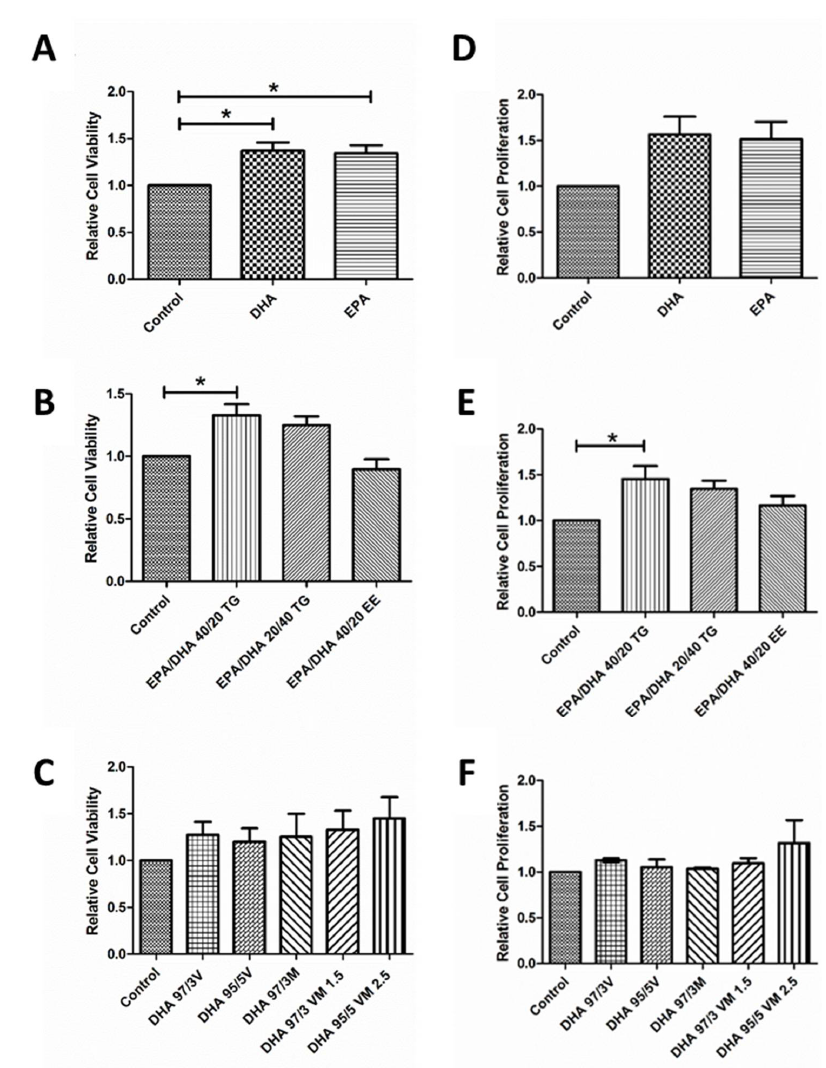
Figure 2. Graphs showing relative cell viability ( A – C ) and proliferation ( D – F ) compared to a control group under normal conditions of groups 1, 2, and 3 of eicosapentaenoic acid / docosahexaenoic acid (DHA/EPA) formulations, respectively ( D – F ). For comparisons, one-way ANOVA with the Bonferroni post-hoc test were used. Data are expressed as mean ± SEM. * p < 0.05. EPA: Eicosapentaenoic acid; DHA: Docosahexaenoic acid; TG: Triglycerides; EE: Ethylesters; PL: Phospholipids. V: Vegetable. M: Marine.